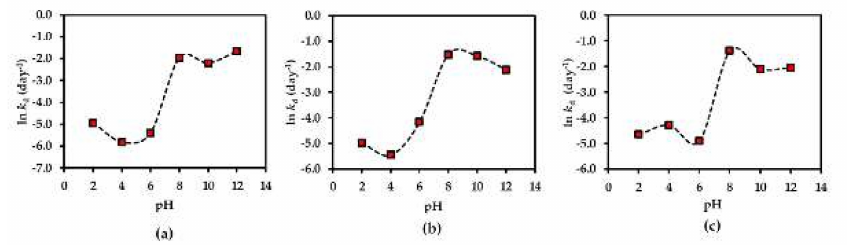
Figure 8. pH-rate profiles of ( a ) compound 1 , ( b ) compound 2 and ( c ) compound 3 in AE solution at 25 ◦ C. Each plot is for a mean value ( n =